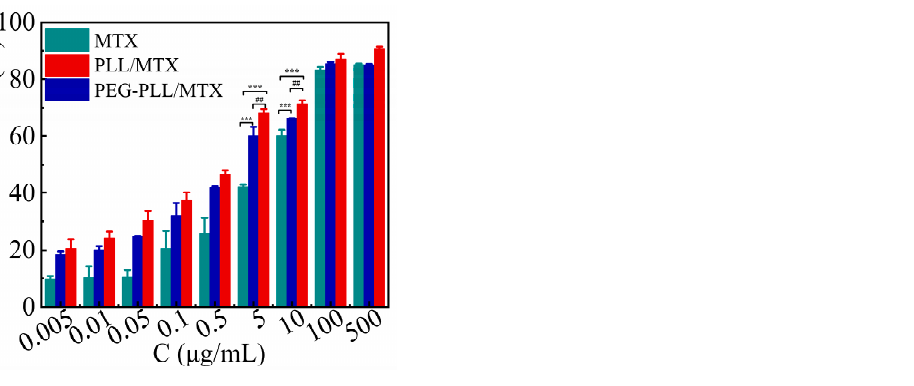
Figure 7. Tumor volume curves of four groups during the 12-day administration ( a ). Tumor weight and the related inhibition rate ( b ) (n = 6) (Group a: glucose solution; group b: MTX injection; group c: PEG-PLL/MTX NPs; group d: PLL/MTX NPs). $$$ p < 0.001 vs. glucose solution; *** p < 0.001 vs. MTX injection; # p < 0.05 vs. PEG-PLL/MTX NPs.